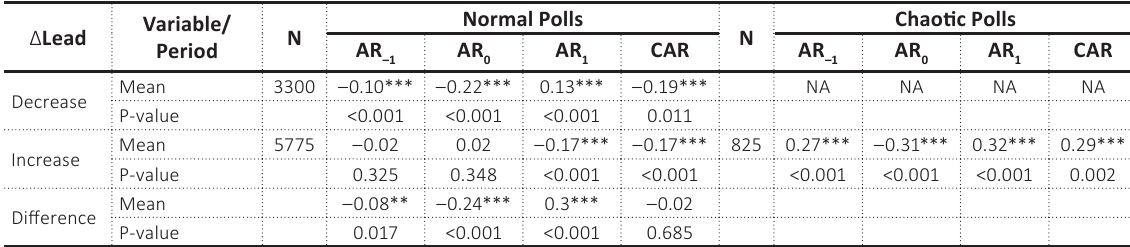
Panel B. CAR for normal and chaotic